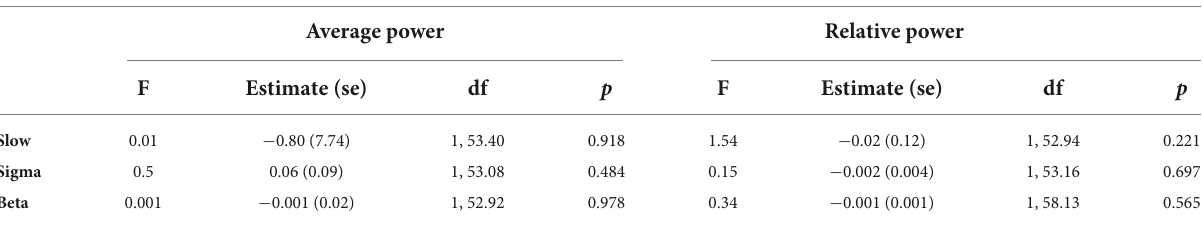
Rawmeans(SD)forPSGvariablesacrossallparticipantswithavailablePSGdata.Boldfontdenotessignificance,p < 0.05. TABLE 3 Between group differences for active CPAP and SHAM CPAP at Time Point 1; Results are presented across the whole night. Between subject main effects of group N = 53 Average power Relative